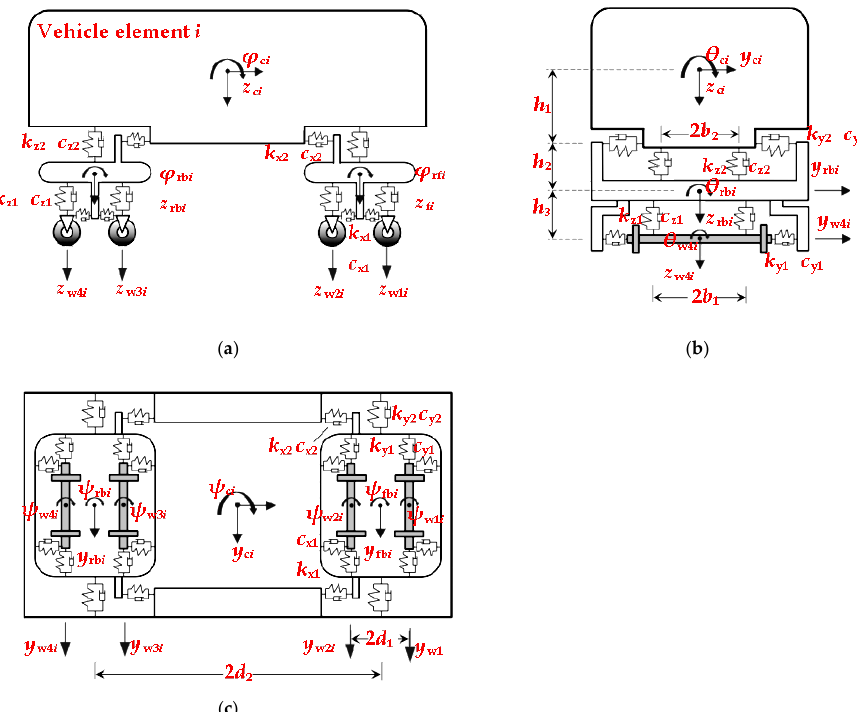
Figure 1. Vehicle element model: ( a ) front view; ( b ) lateral view; ( c ) top view.